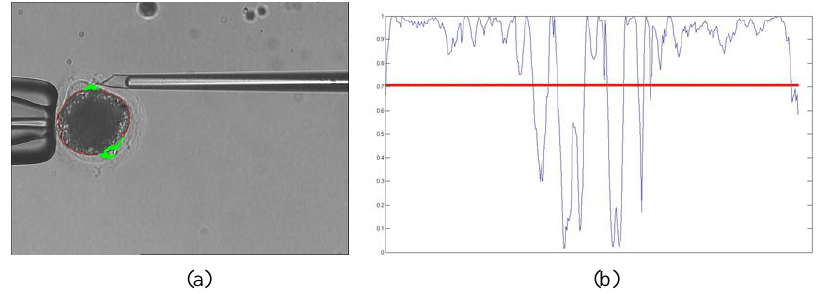
Figure 7. Polar body position prediction result. ( a ) The prediction result; ( b ) The cosine value.